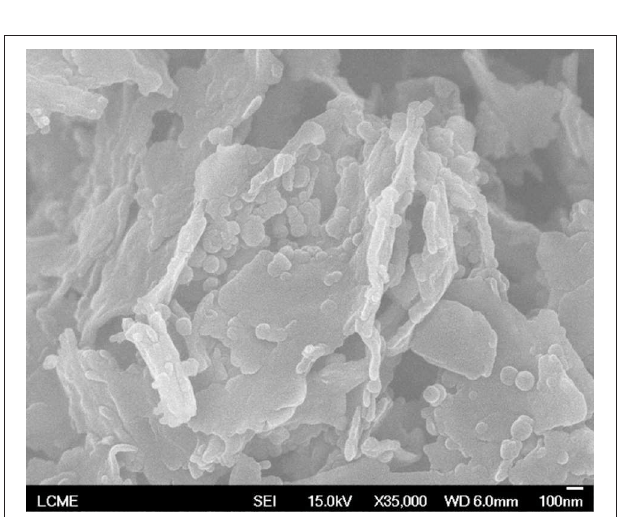
FIGURE 2 | FESEM micrograph of nanostructured conductive additive of